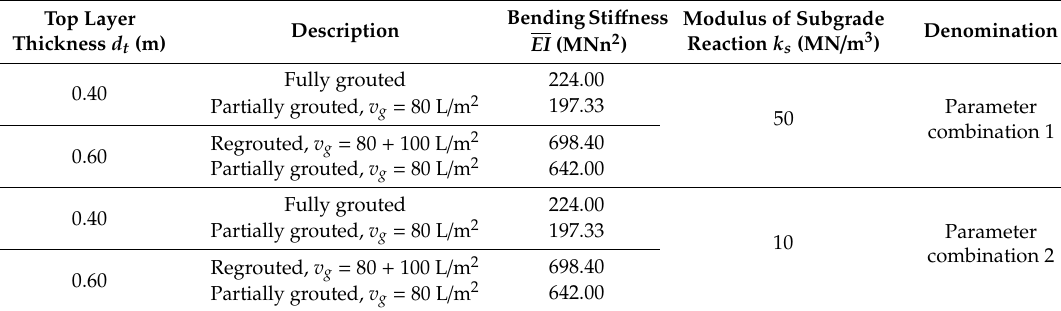
Table 6. Model parameter combinations for the MGRRs of the GWK